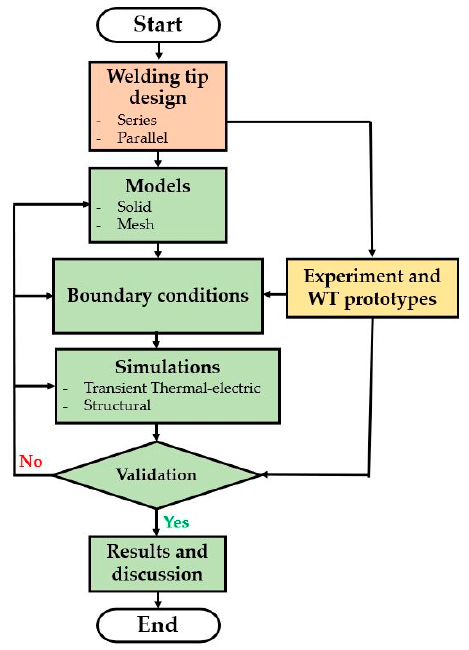
Figure 4. A flowchart of the methodology.